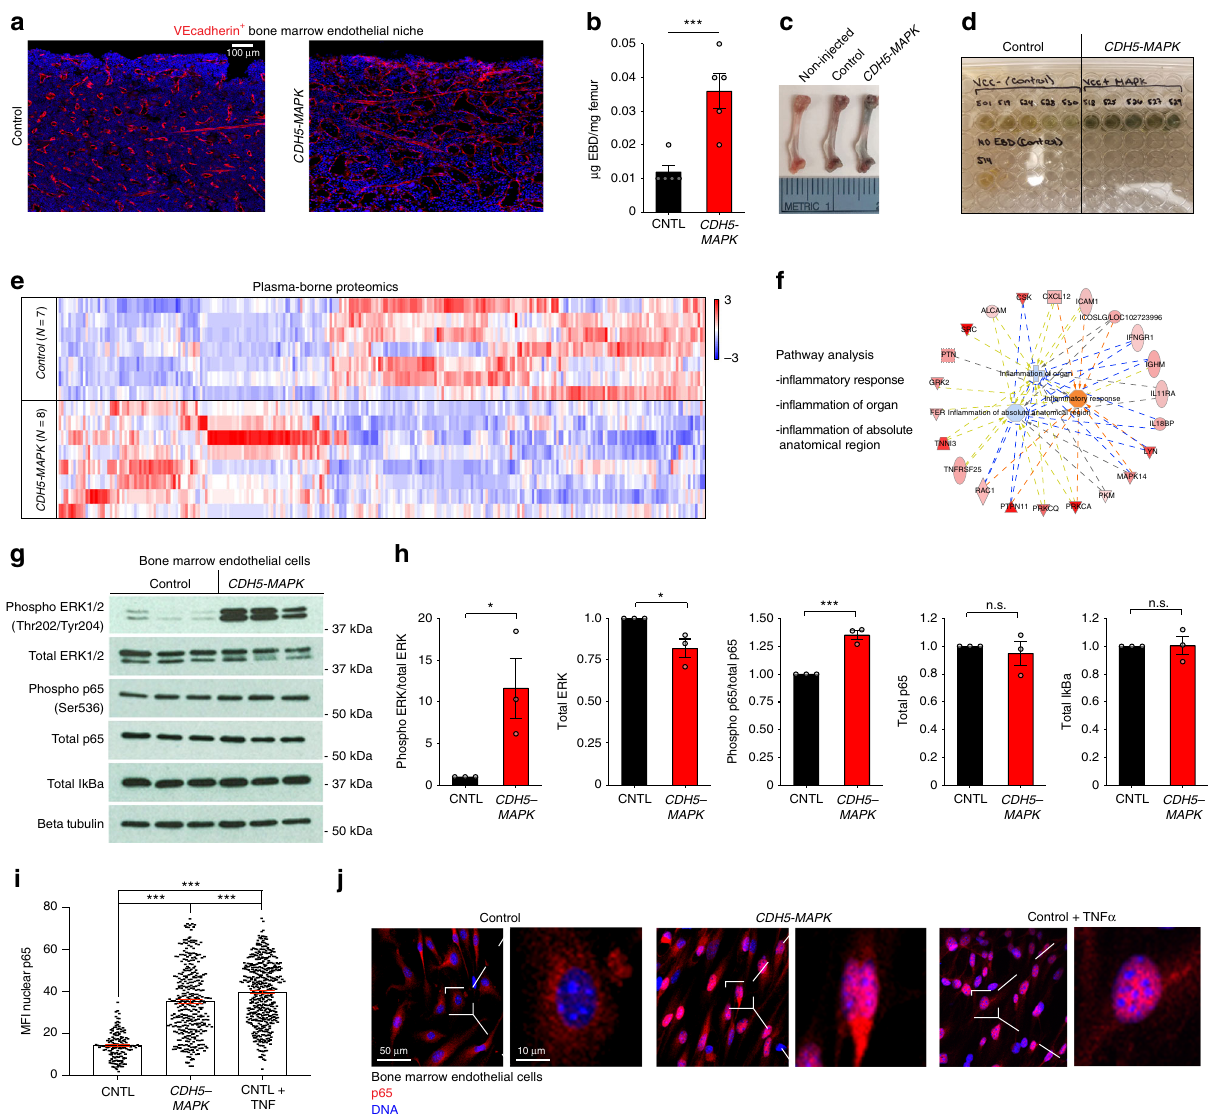
Fig. 2 CDH5-MAPK mice display systemic and BM-localized in fl ammation. a Representative immuno fl uorescence images of femurs intravitally labeled with a vascular-speci fi c CD144/VE-cadherin antibody (red) demonstrating vascular dilatation in CDH5-MAPK mice. b Quanti fi cation of Evan ’ s Blue Dye (EBD) extravasation ( n = 5 mice/cohort). c Representative images of femurs isolated from mice injected with EBD. d Microtiter plate demonstrating intensity of extracted EBD for each sample. Non-injected controls were used to determine baselines. e Heatmap of 242 differentially expressed proteins in plasma of CDH5-MAPK mice identi fi ed by proteomic analysis ( n = 7 control and n = 8 CDH5-MAPK mice). Color scales represent relative protein abundance re fl ecting mean fl uorescence intensities of SomaLogic aptamer-based ELISA. Raw data included in Supplementary Data 1 and Source Data. f Ingenuity Pathway Analysis of differentially expressed proteins demonstrating that in fl ammatory responses are over-represented in CDH5-MAPK mice. g , h Immunoblot analysis of BMECs isolated from CDH5-MAPK mice demonstrating that MEK1DD expression in BMECs results in an increase in ERK1/2 and p65 phosphorylation ( n = 3 biological replicates per genotype). i , j Representative immuno fl uorescence images and quanti fi cation demonstrating increased levels of nuclear p65 in BMECs derived from CDH5-MAPK mice as compared to controls. Control BMECs treated with TNF α (10 ng/mL for 15min) were used as a positive control for the assay. Each dot within the bar graph represents nuclear p65 staining intensity per individual cell. Error bars represent sample mean±SEM. Statistical signi fi cance was determined using two-tailed unpaired Student ’ s t -test. * P ≤ 0.05; *** P <0.001; n.s. P